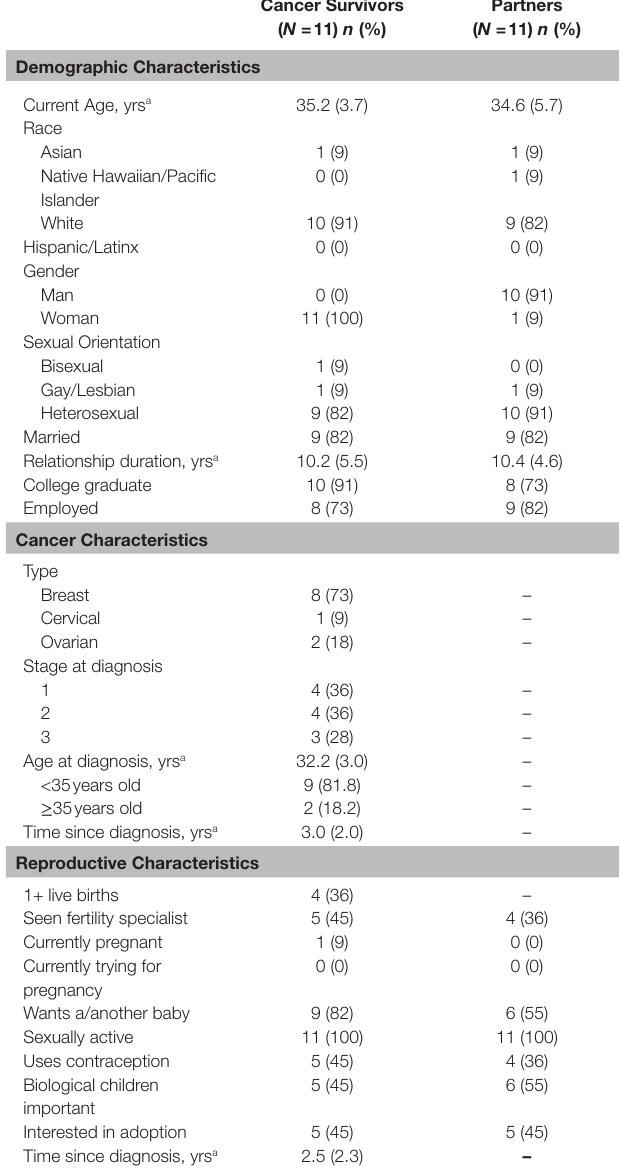
TABLE 1 | Participant